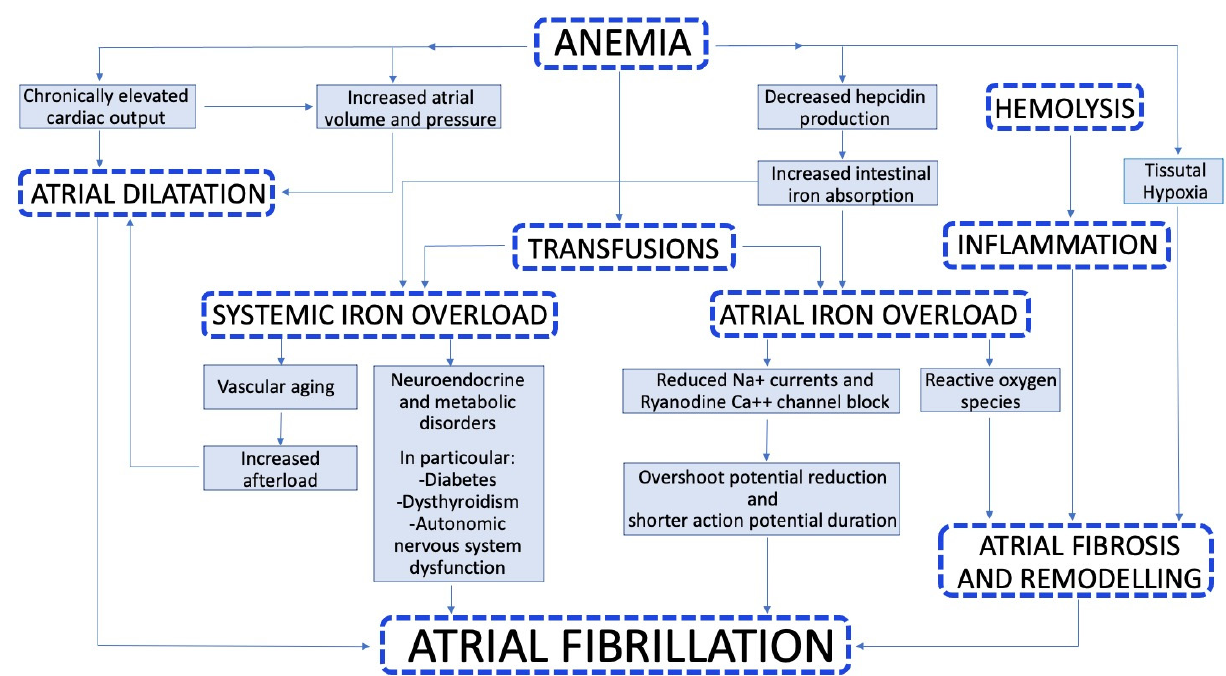
Figure 1. Pathophysiology of atrial fibrillation in β -thalassemia.